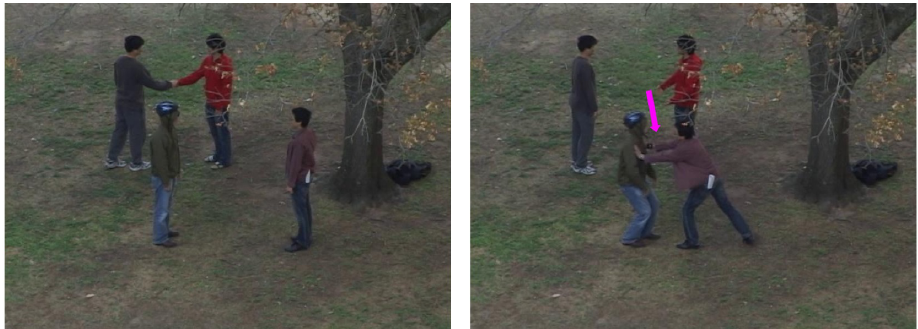
Figure 17. Failure case 4 threat level interpretations. System threat evaluation output—Decreases, Human expert opinion output—Increases.